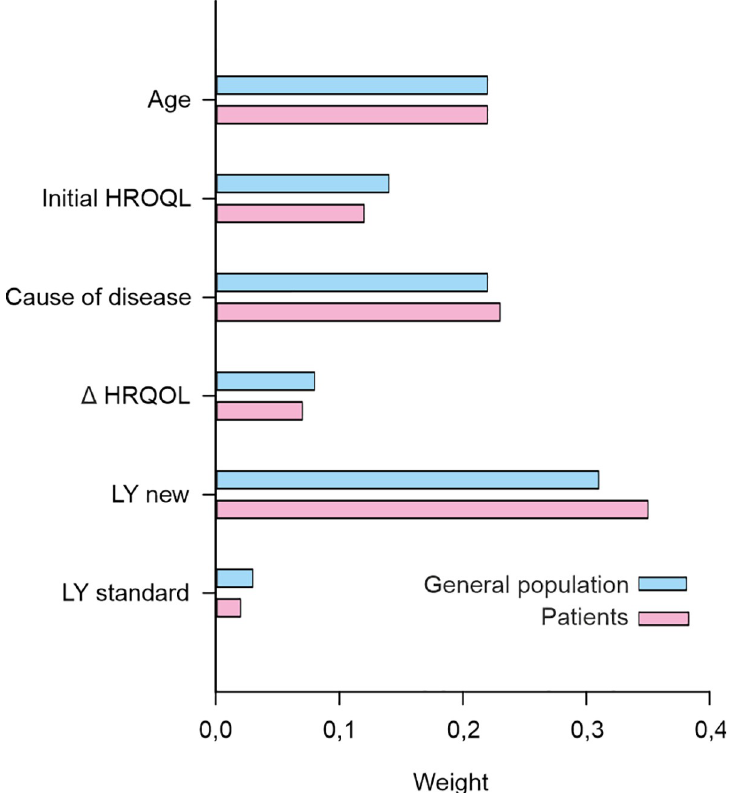
Fig 2. Attribute weights for the general population group and the patient